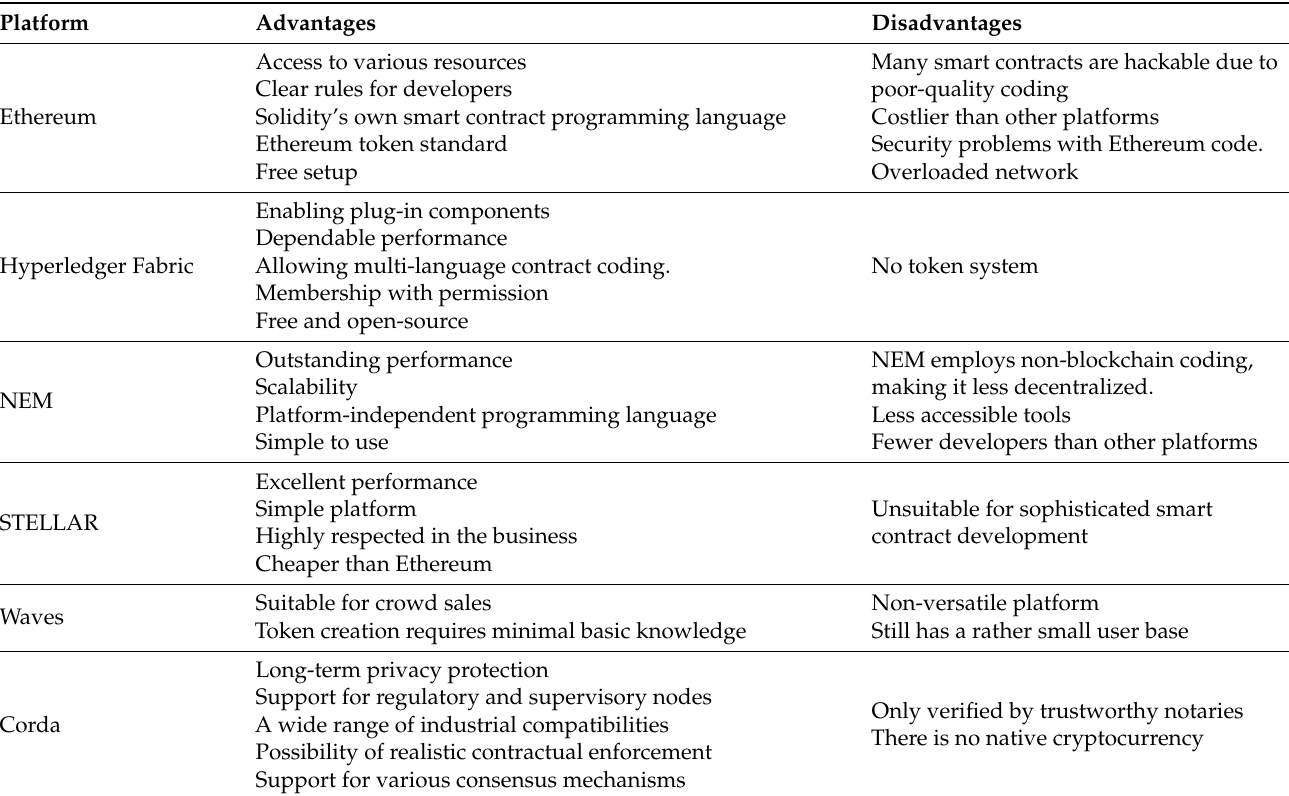
Table 1. Various platforms of smart contracts: pros and